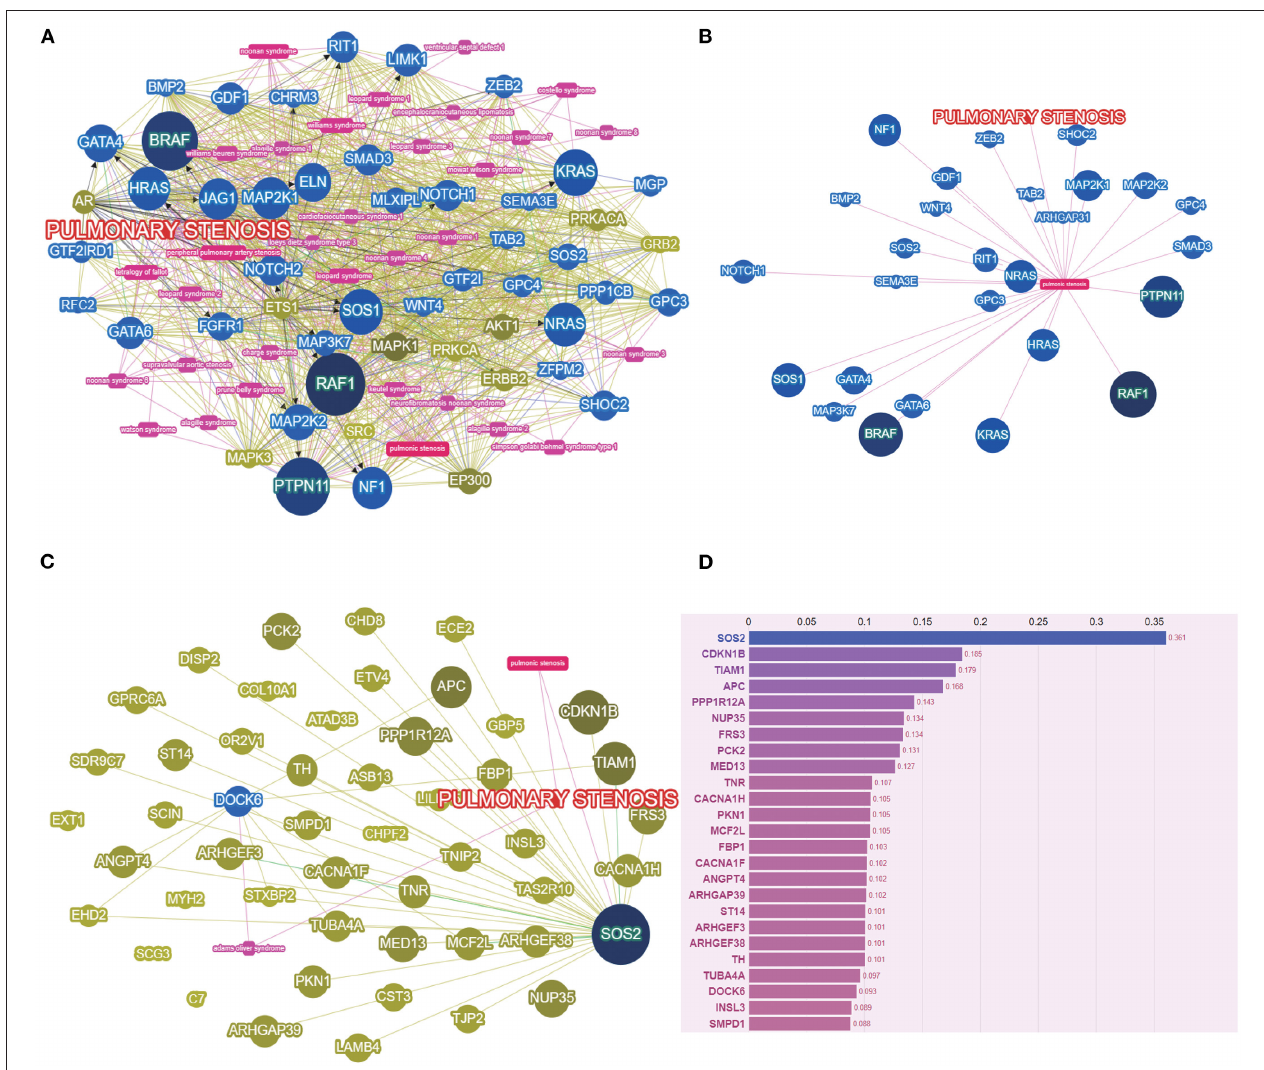
FIGURE 3 | The PS-associated genes were identified by gene-based burden analysis. (A) The known genes related to the PS phenotypes were searched and summarized. (B) Genes associated with PS phenotypes were shown after excluding the genes related to the syndromes. (C) The association between genes tested and disease phenotype was predicted. (D) The score of genes tested was listed by Phenolyzer